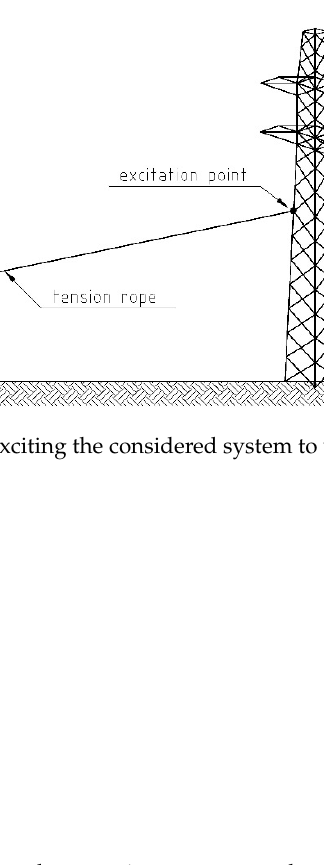
Figure 3. Cross-section of the considered supporting structure at the middle of its height: location of sensors ( ● ) and point in which the excitation was provided ( ♦ ).